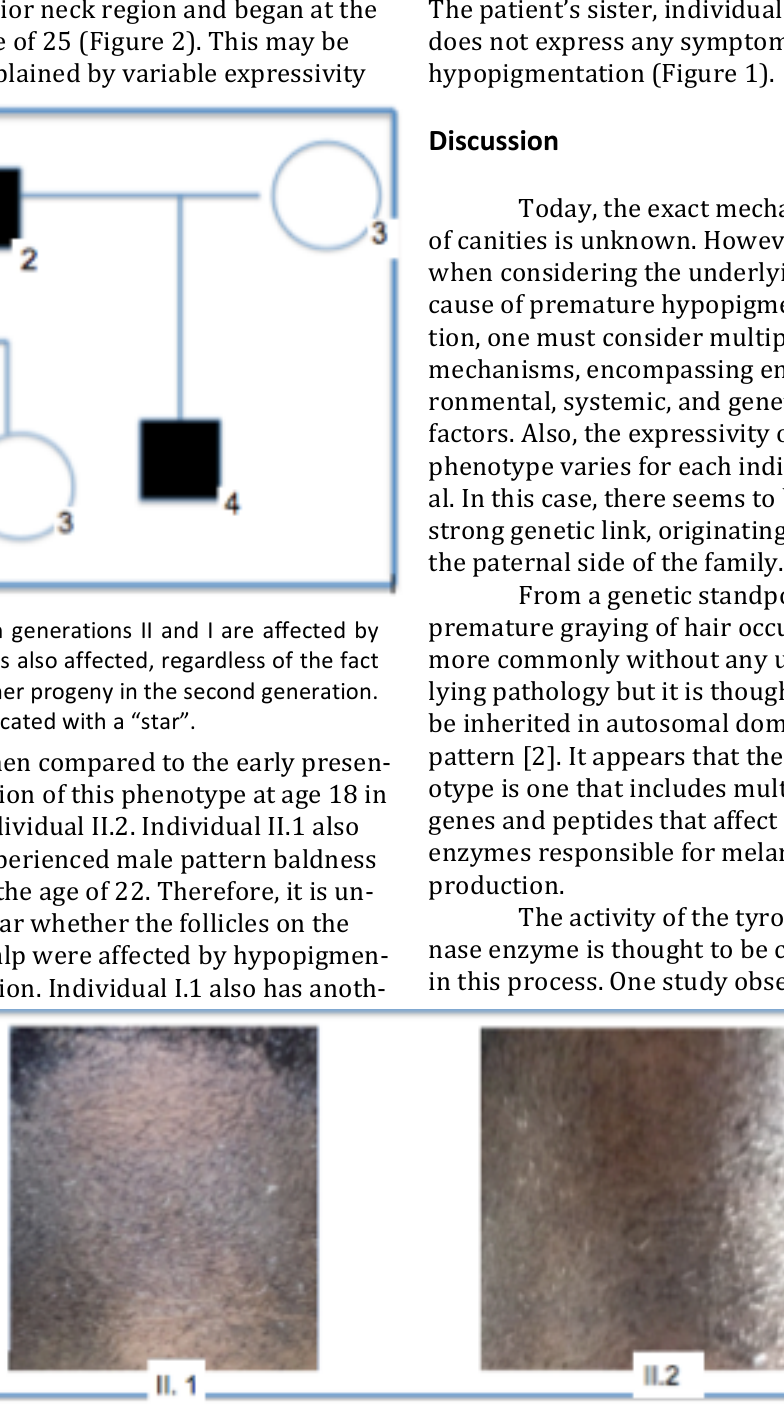
Figure 2. The photo on the left is individual II.1 shown in the pedigree. The pho-­‐ to on the right is individual